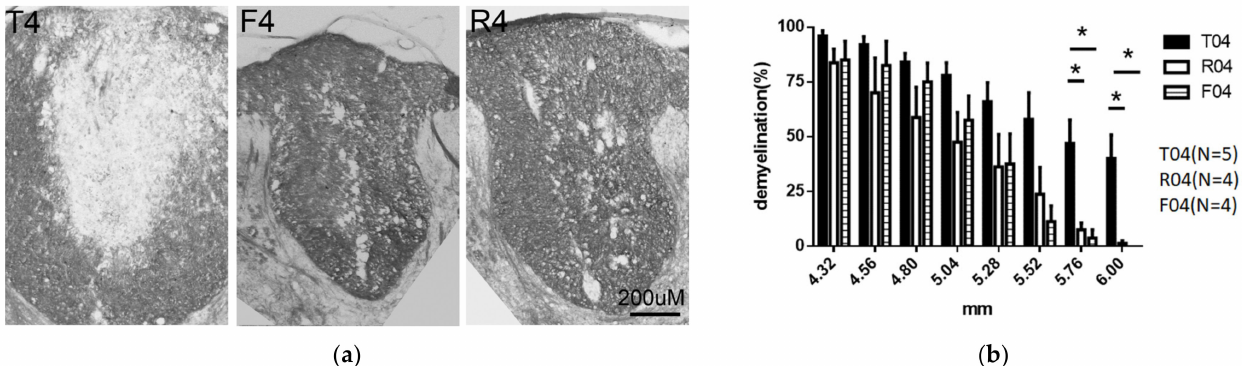
Figure 12. ( a ) Cross-sections showing myelin in the dorsal funiculus that was stained with Luxol fast blue at 5.5 mm to 5.75 from the trauma center. The myelin in supposedly proximal degenerative site in the R4 and F4 rats was almost intact; the degeneration found in the T4 rats was more profound. Animal number used: T4 ( n = 5) R4 ( n = 4) F4 ( n = 4). ( b ) The proportion of demyelinated area to the total dorsal funiculus was manually judged and descriptive statistics were obtained. Luxol fast blue staining at 4 days P.O. in the transected rats demonstrated that the myelin was more destructed when compared to those in R4 and F4. Tested with pairwise t -test *: p < 0.05. Data are presented with SEM. Animal number used: T4 ( n = 5) R4 ( n = 4) F4 ( n =